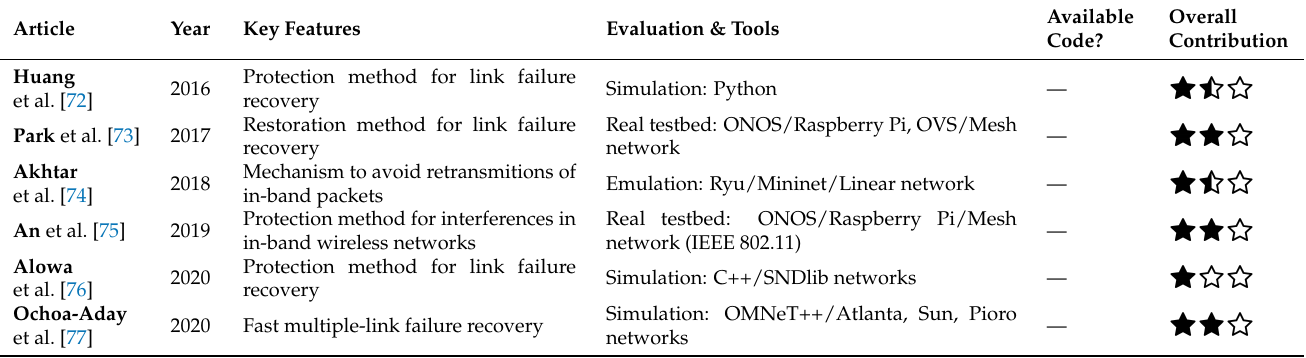
Table 3. Summary table of in-band proposals that support fast failure